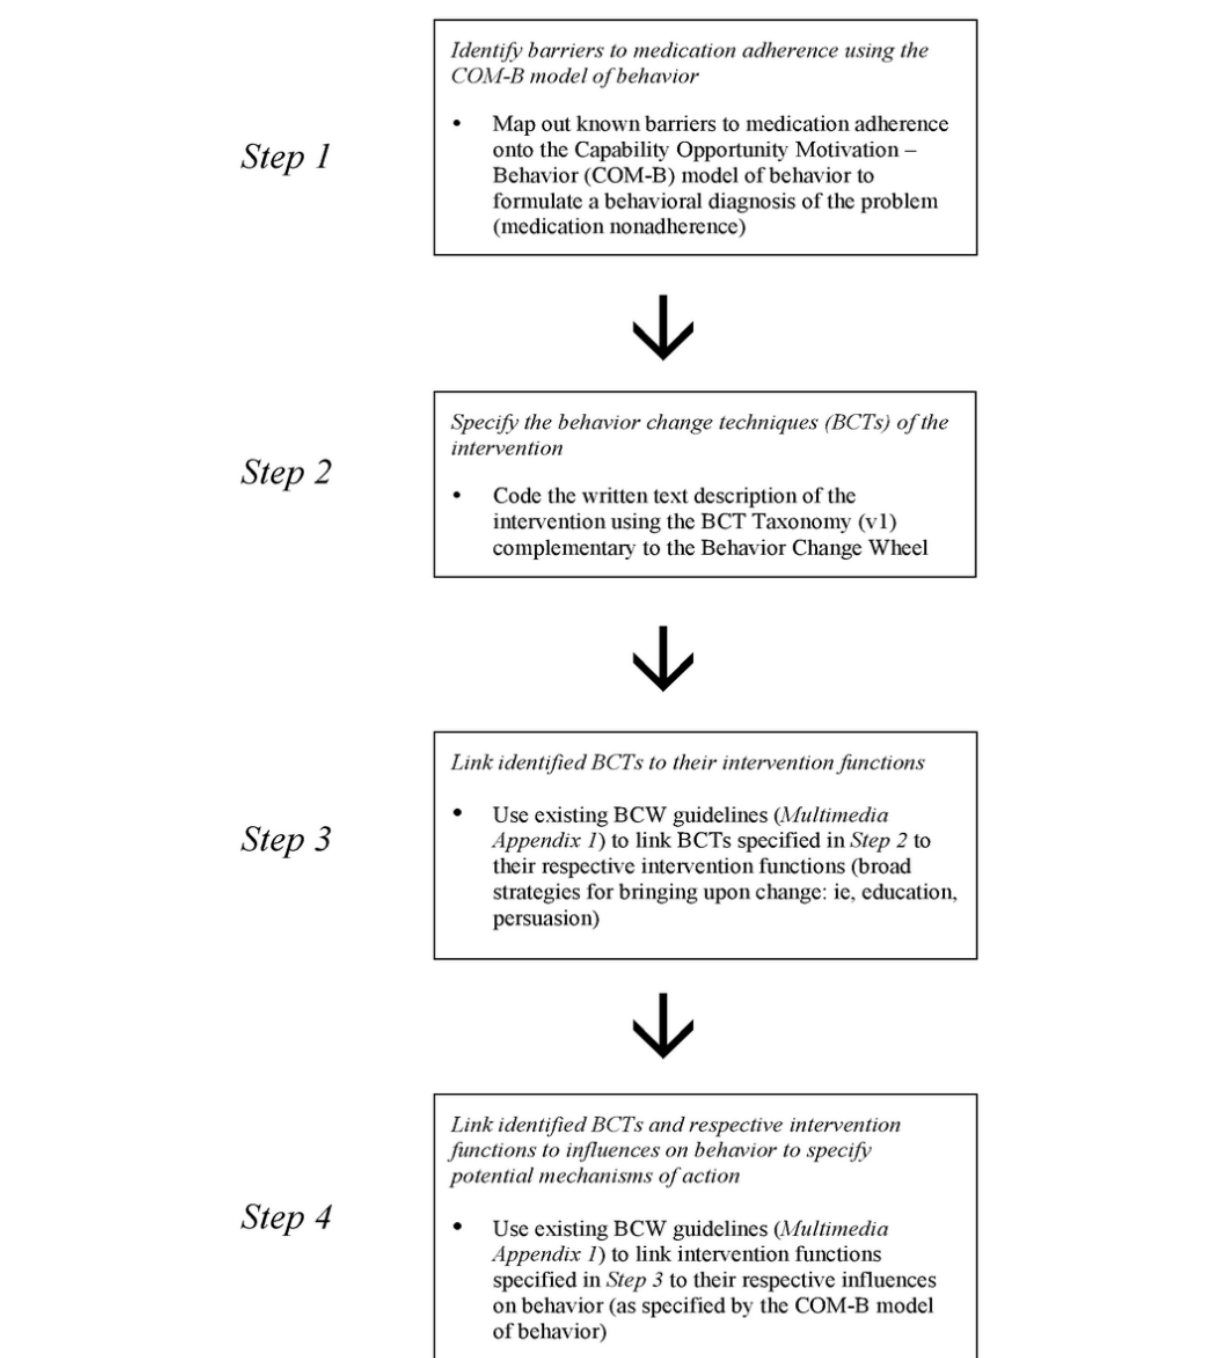
Figure 3. Determining potential mechanisms of action of an intervention using the Behavior Change Wheel